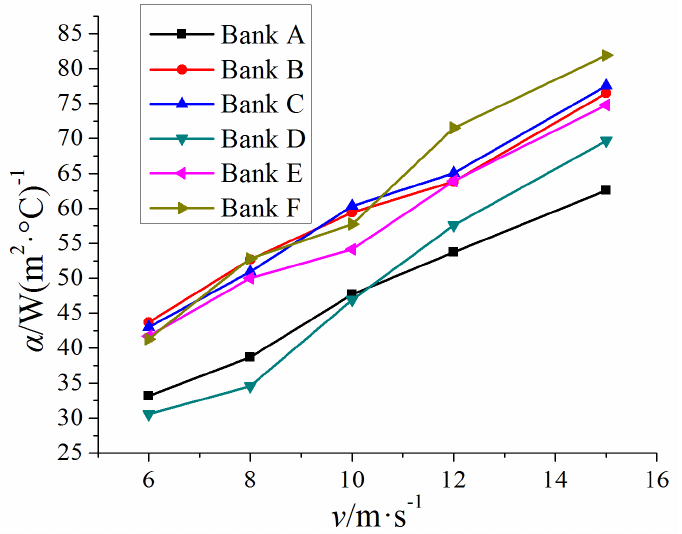
Figure 5. Relationship between convective heat transfer coefficient α and air velocity v